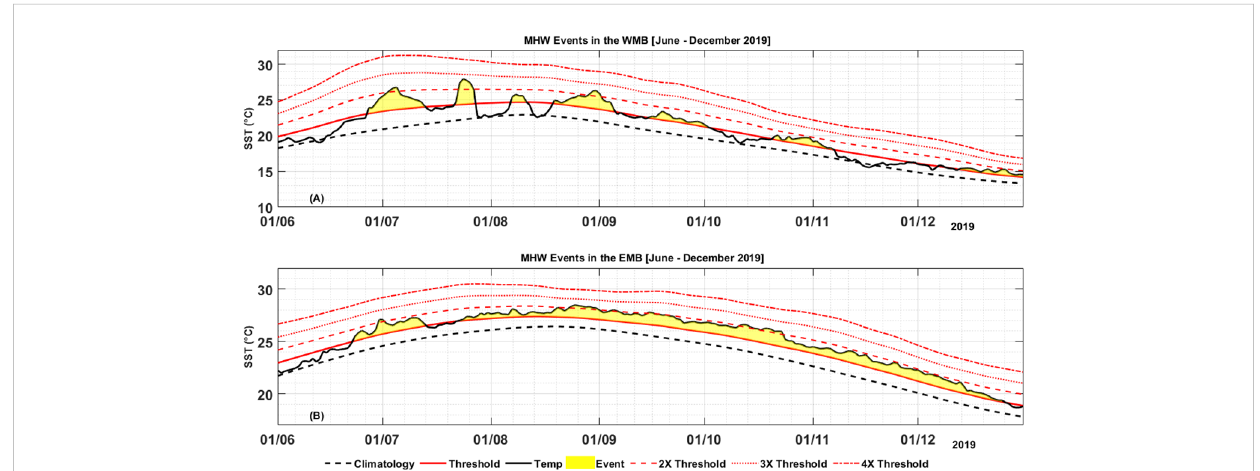
FIGURE 7 MHW events between June and December 2019 in (A) WMB and (B) EMB. The yellow shaded area refers to the MHW event. The black solid line represents the SST, the black dotted line represents the climatology, the red solid line represents the threshold, and the red dotted lines de fi ne the MHW categories. The MHW categories are moderate (when SST exceeds the threshold), strong (when SST exceeds 2X threshold), severe (when SST exceeds 3X threshold), or extreme (when SST exceeds 4X threshold).